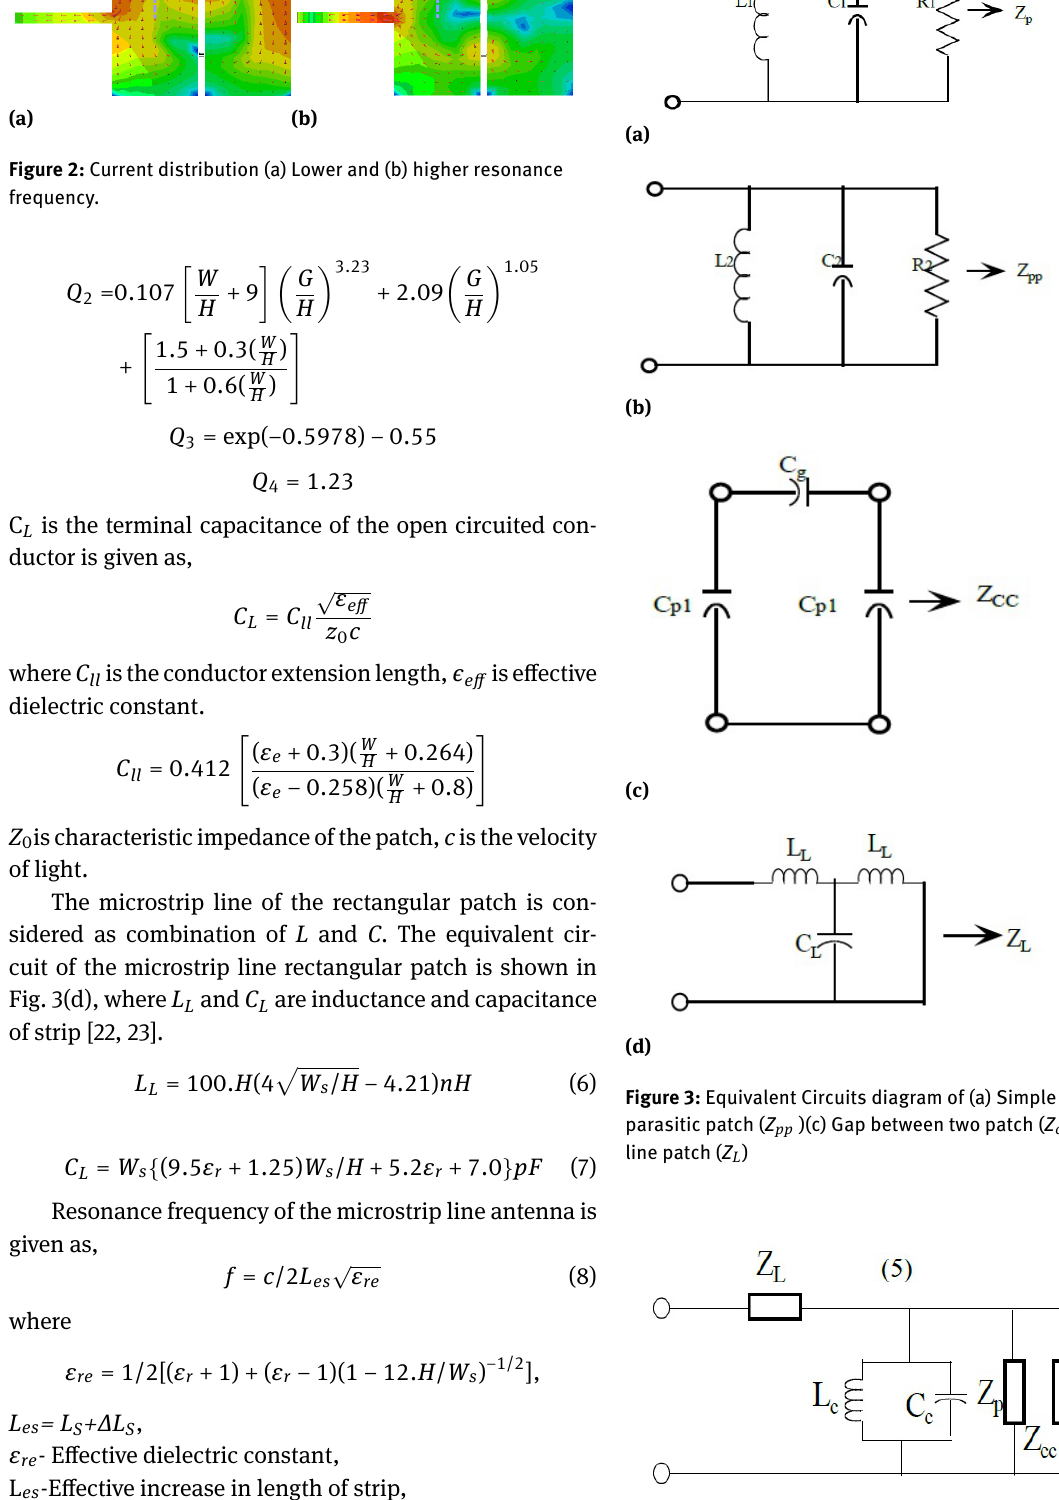
Figure 4: Equivalent circuit diagram of the